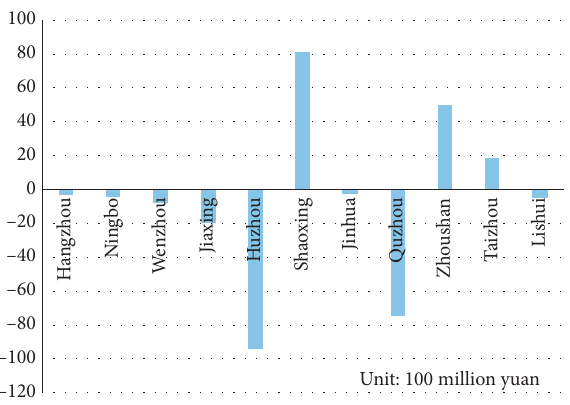
Figure 2: Comparison of competitiveness shift component of primary